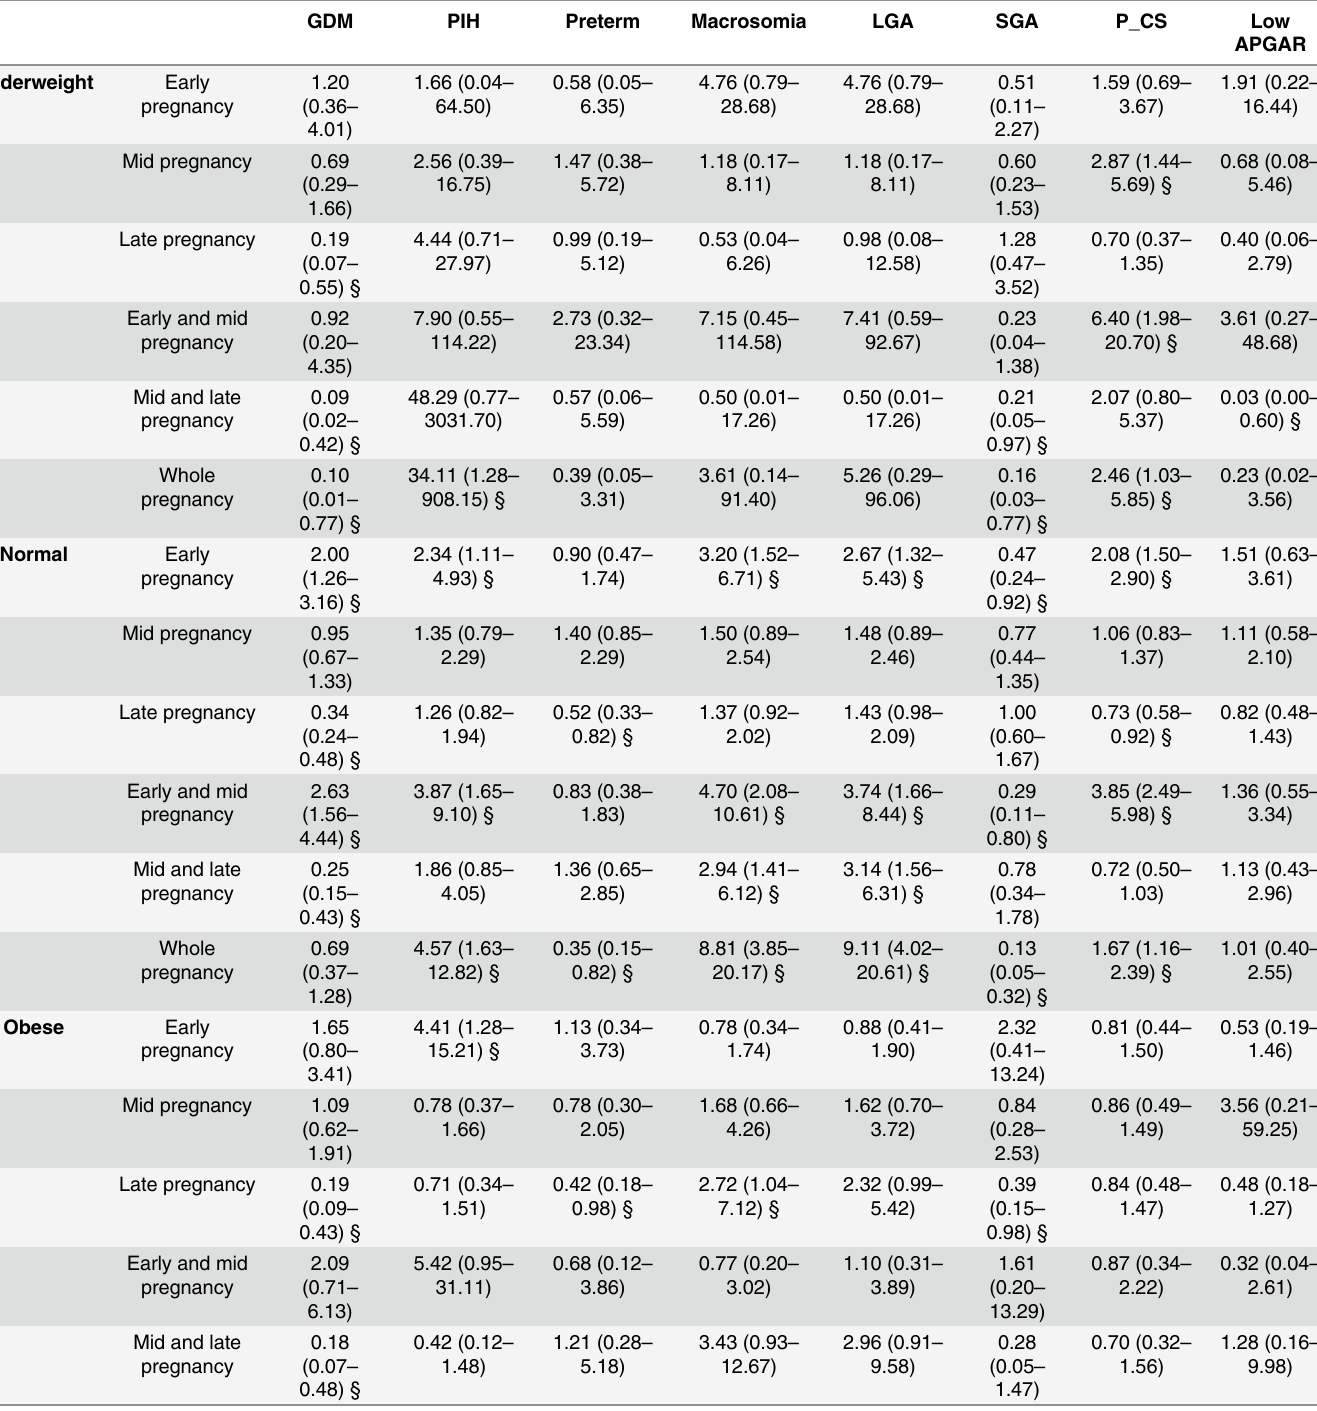
Table 4. Risk analysis of developing adverse pregnancy outcomes – pre-pregnancy BMI. GDM